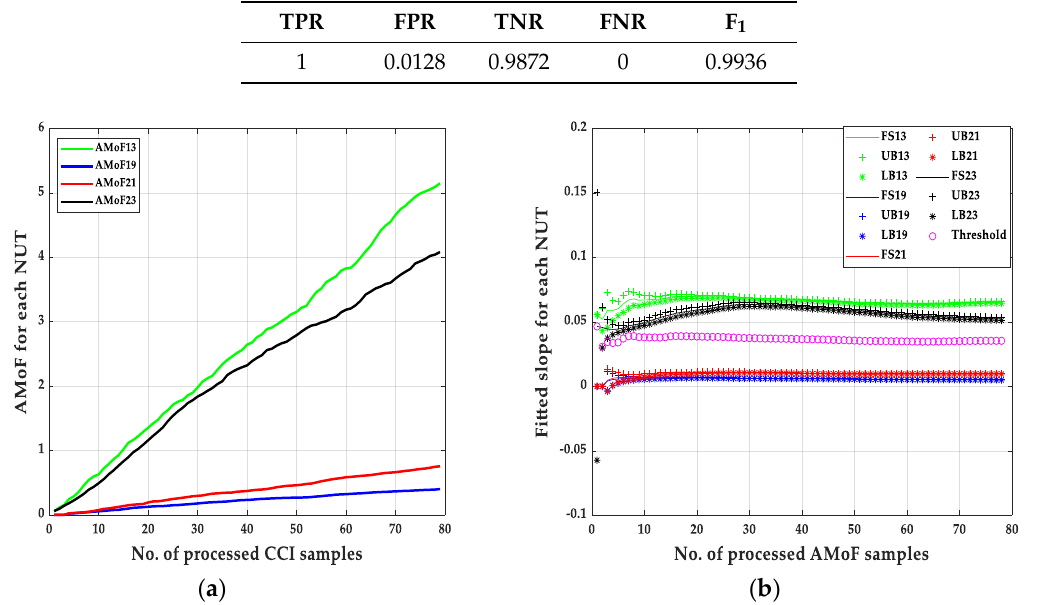
Figure 4. The AMoF and the fitted slope for di ff erent nodes for scenario NS15P7: ( a ) The AMoF for di ff erent NUT; ( b ) the fitted slope for NS15P7_BH_RWP 25 /